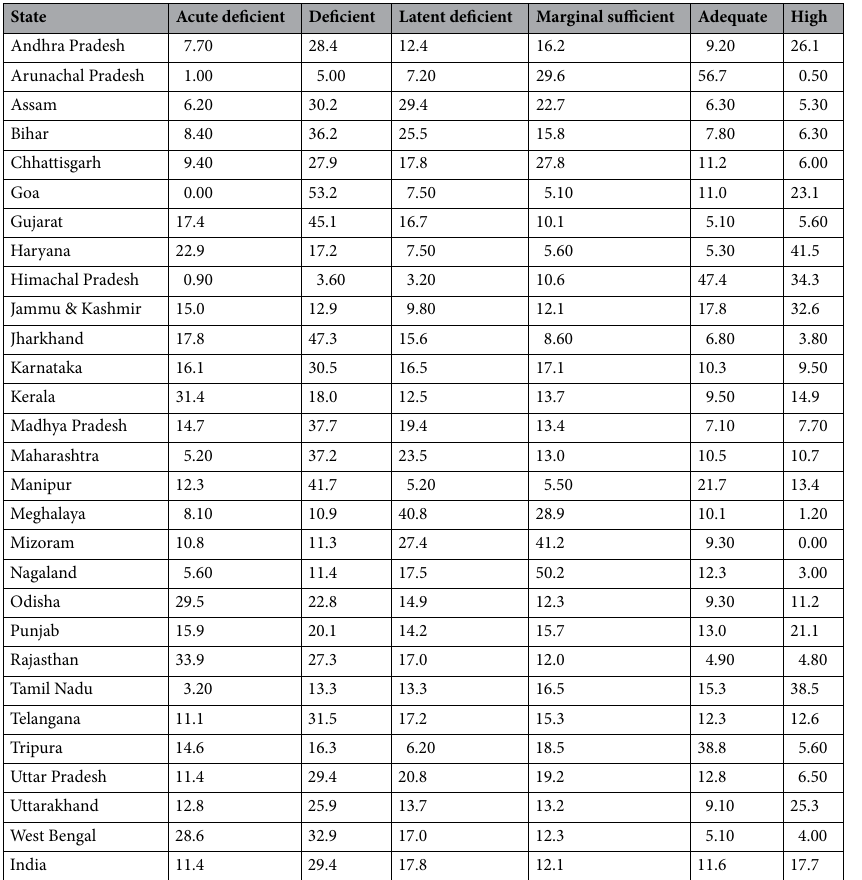
Table 2. State-wise deficiency (% of soil samples) status of available